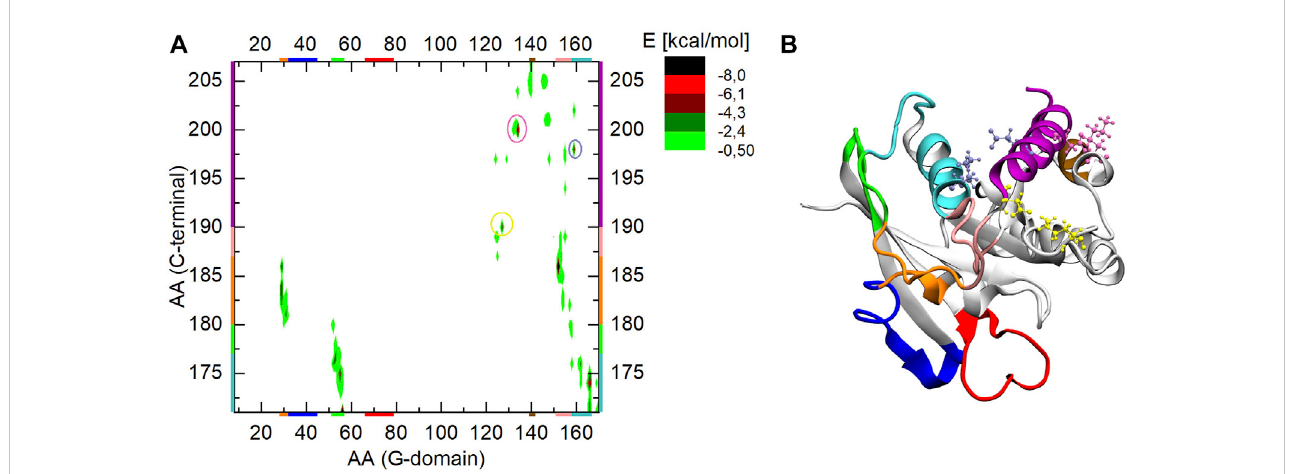
FIGURE 6 (A) The interaction energy map between the G-domain and the C-terminus during MD simulation of Ran-GDP, (B) 3D structure of Ran-GDP. The interacting regions are color-coded both along the axes or encircled on the graph and mapped with identical coloring onto the 3D structure. The encircled parts of the (A) part highlight the strong ionic interactions of the C-terminal helix denoted by similar color CPKs on the (B) part of the fi